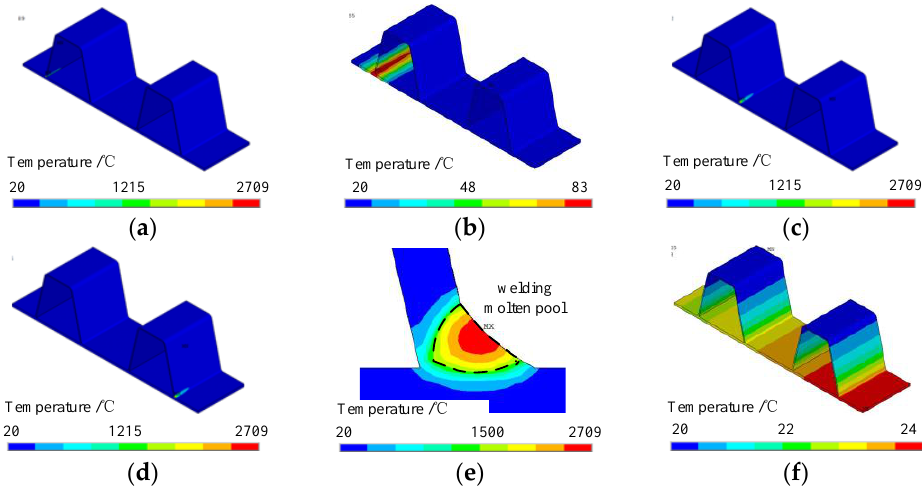
Figure 7. Temperature distribution in the thermal field (unit: degrees Celsius): ( a ) t = 30 s; ( b ) t = 150 s; ( c ) t = 360 s; ( d ) t = 1020 s; ( e ) the shape of welding molten pool at t = 1020 s; ( f ) t = 3420 s.